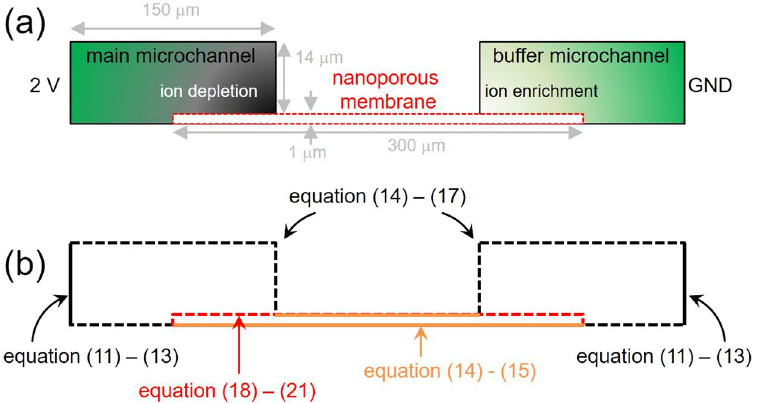
Figure 2. ( a ) Schematic diagram of numerical domain for the protruded nanoporous membrane system. The size of the buffer microchannel was identical to main microchannel. The three-layer means “microchannel”- “membrane”-“microchannel”. Note that the figure was not to scale. ( b ) Schematic diagram of summarized boundary conditions. The boundaries were divided into four types which were represented as black solid, black dash, orange solid and red dash